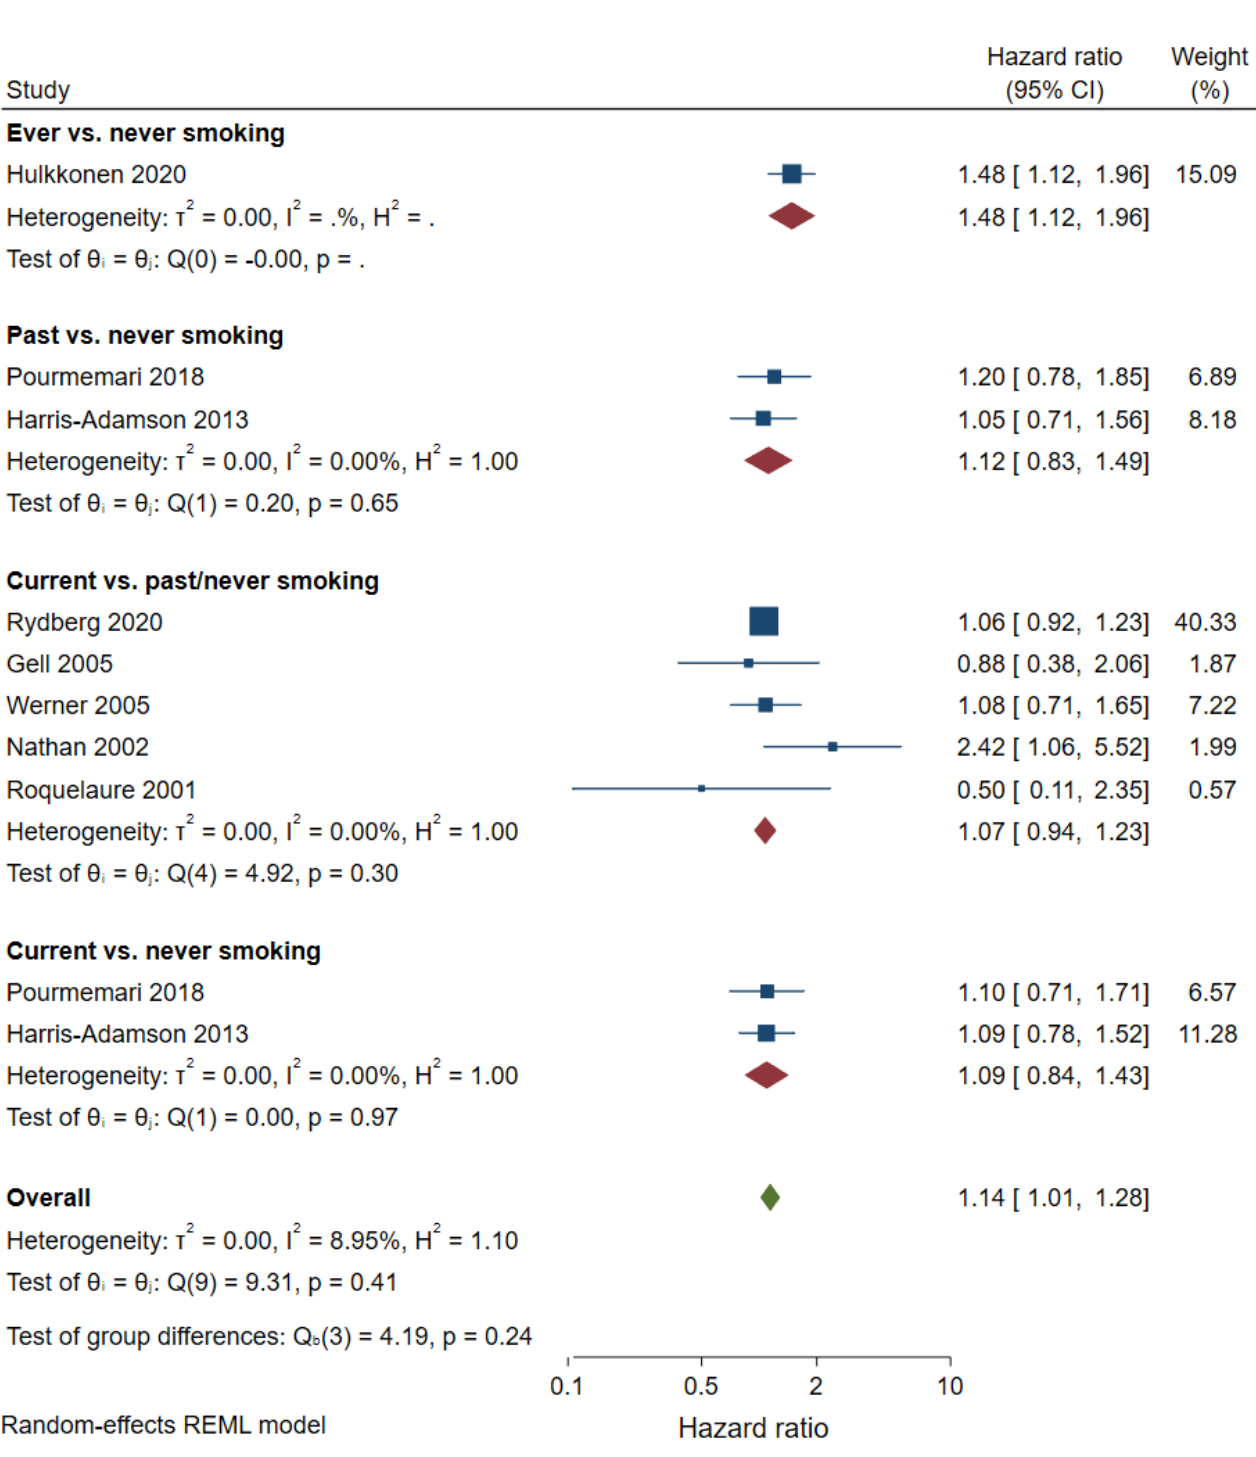
Figure 4. Meta-analysis of prospective cohort studies on smoking and CTS.